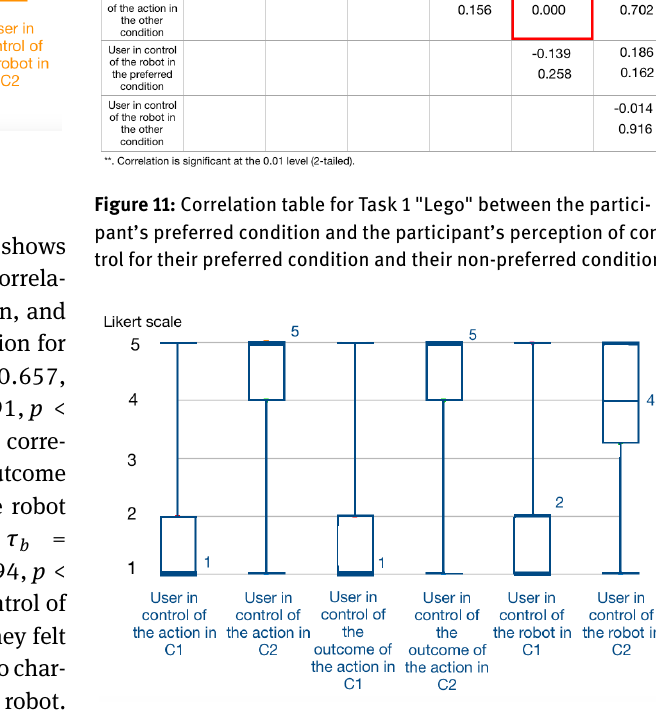
Figure 12: Task 2: booking a doctor’s